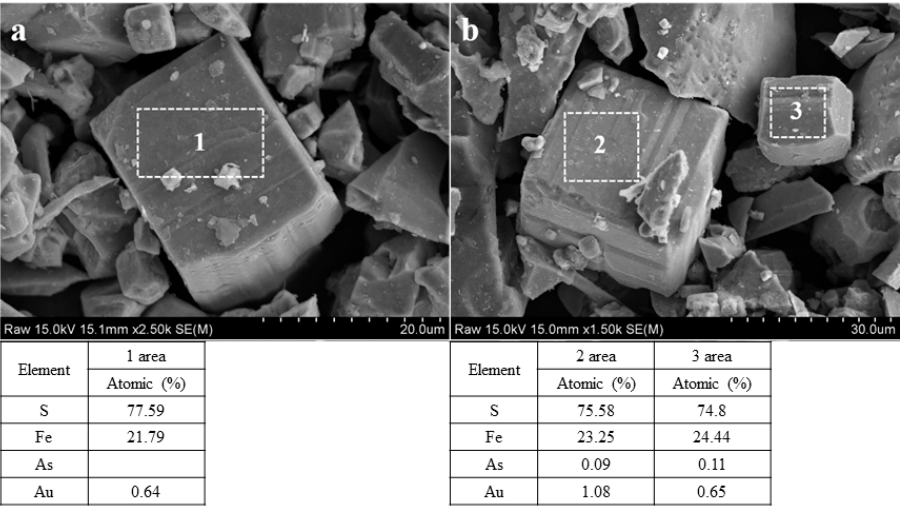
Figure 3. SEM-EDS (Scanning Electron Microscopy-Energy-dispersive X-ray spectroscopy) of pyrite in the refractory gold concentrate.